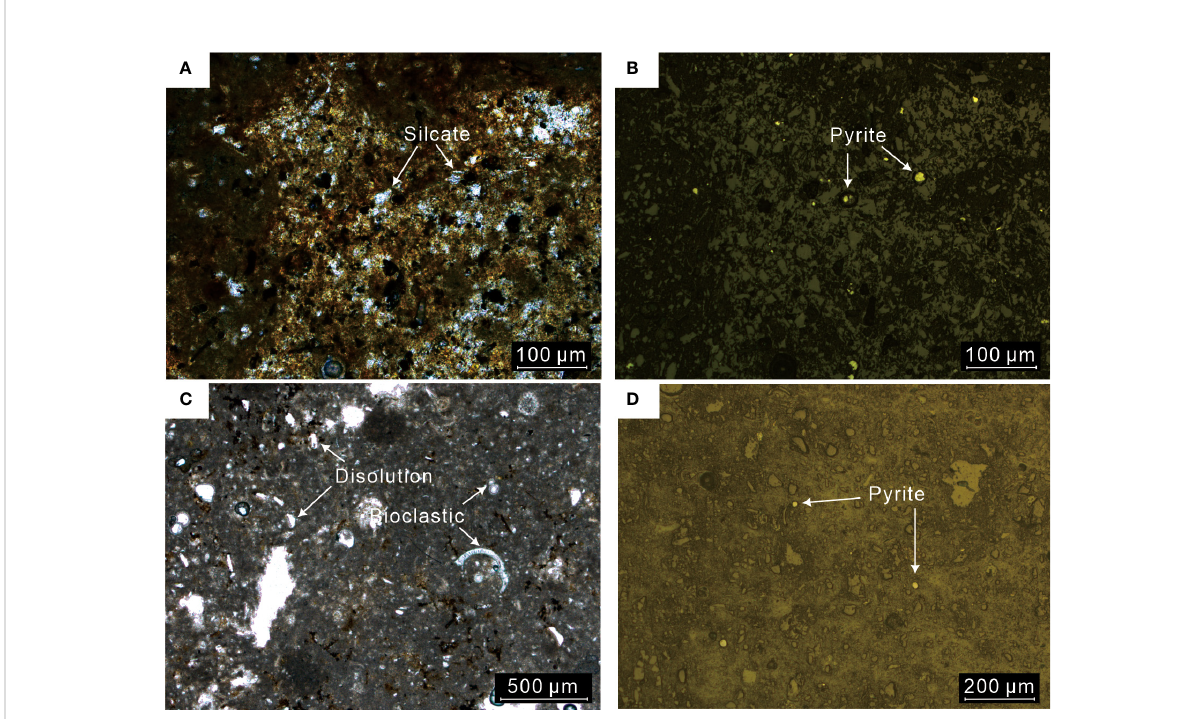
FIGURE 2 Thin section photomicrographs of carbonates R1 (A, B) and R4 (C, D ). (A, C) Under plane-polarized light; (B, D) under re fl ected